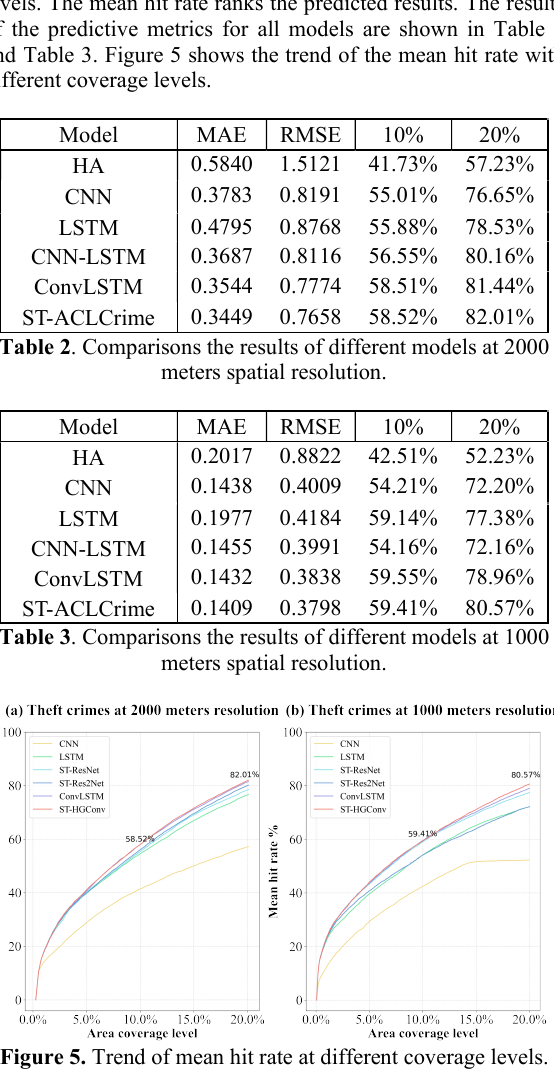
Table 1. Two-level spatial unit division.